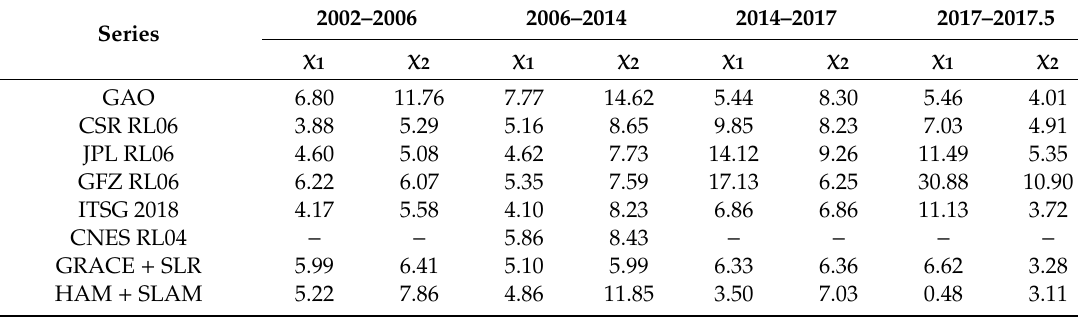
Figure 5. Trends in χ 2 component of GAO, GSMAM, GRACE + SLR, and HAM + SLAM together with their errors for four time periods: ( a ) 2002–2006, ( b ) 2006–2014, ( c ) 2014–2017, ( d ) 2017–2017.5. The values are given in mas / year. The shades show the errors of trends determined. Note that CNES RL04 data covered only the period 2006–2014 in full. Table 2. Standard deviation of GAO, GSMAM, GRACE + SLR, and HAM + SLAM time series for four considered time periods. Note that CNES RL04 was included only for the period 2006–2014.